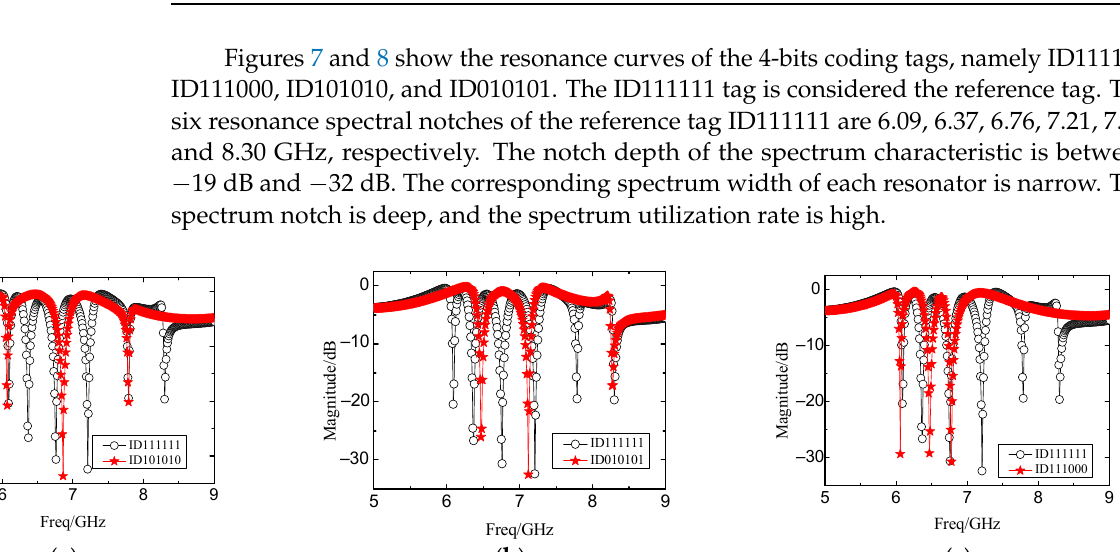
( c ) Figure 8. The simulation removed the resonance curves of the 6-bits U-shaped slot resonator chipless tags with a logic state of “0”: ( a ) ID111111 and ID101010; ( b ) ID111111 and ID010101;( c ) ID111111 and ID111000. 4. Experimental Results Figure 9 is the test system of a retransmission chipless tag based on multi-state res- onators. The experimental setup architecture was composed of a UWB reader, Tx/Rx an- tennas and a chipless tag. A Ceyear vector network analyzer 3672D was used as an al- ternative to the UWB reader. The two ports of the network analyzer were, respectively, connected to the L-shaped slot-loaded stepped-impedance UWB antennas [41], which were orthogonal to each other to improve the transceiver isolation of the reader. The tag was connected to two orthogonal L-shaped slot-loaded stepped-impedance UWB an- tennas through two microwave adapters. In order to prevent the received signal and the transmitted signal of the tag from interfering with each other, the two-sided UWB an- tennas of the tag were also orthogonal to each other. Both the reader antennas and the tag antennas were fixed on the foam, 10 cm apart. The gain of the L-shaped slot-loaded stepped-impedance UWB antenna was 4 dBi to 8.54 dBi in the range of 2.39 GHz to 13.78 GHz.